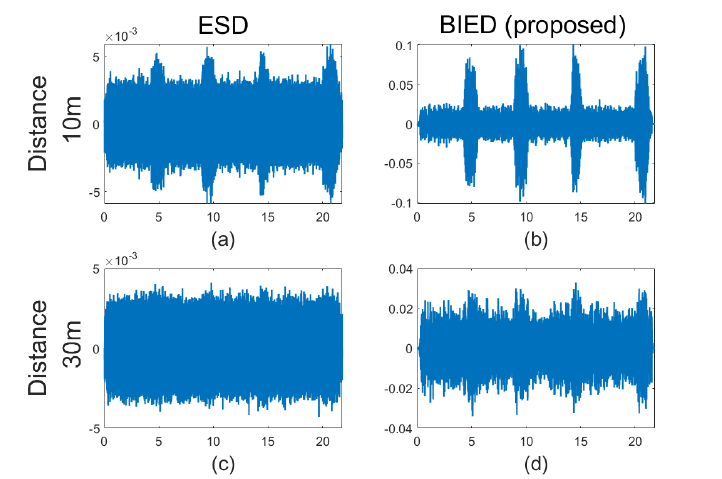
Figure 10. Pre-processed signals in the ESD method and the BIED method. ( a ) ESD at the distance of 10 m; ( b ) BIED at the distance of 10 m; ( c ) ESD at the distance of 30 m; ( d ) BIED at the distance of 30 m.